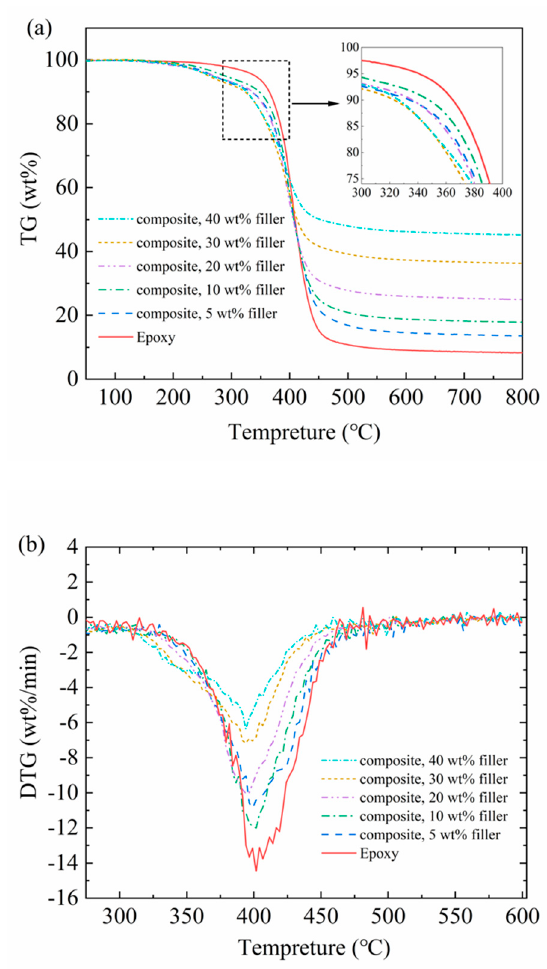
Figure 5. Weight loss curves of epoxy and HF-Ti 3 C 2 T x / epoxy composites under Ar, ( a ) TG, ( b ) DTG. Table 1. Thermogravimetric data of HF-Ti 3 C 2 T x , epoxy and their composites.